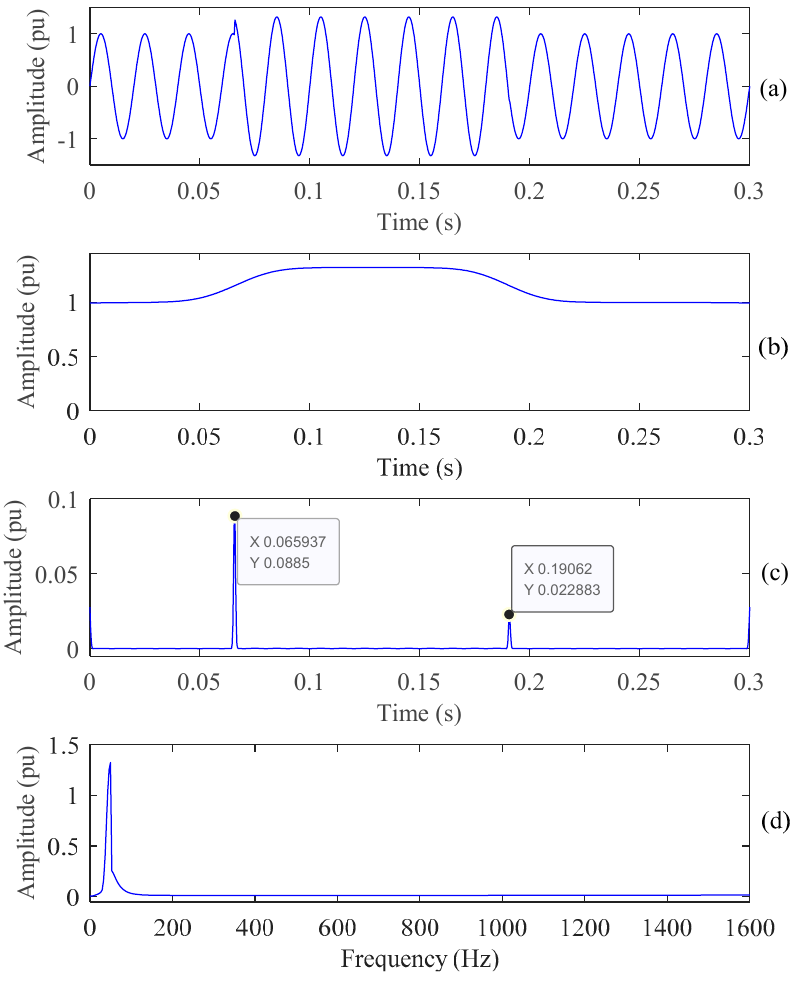
Figure 5. Voltage swell and related STA : ( a ) Voltage swell; ( b ) TvA ; ( c ) TvHFA ; ( d )